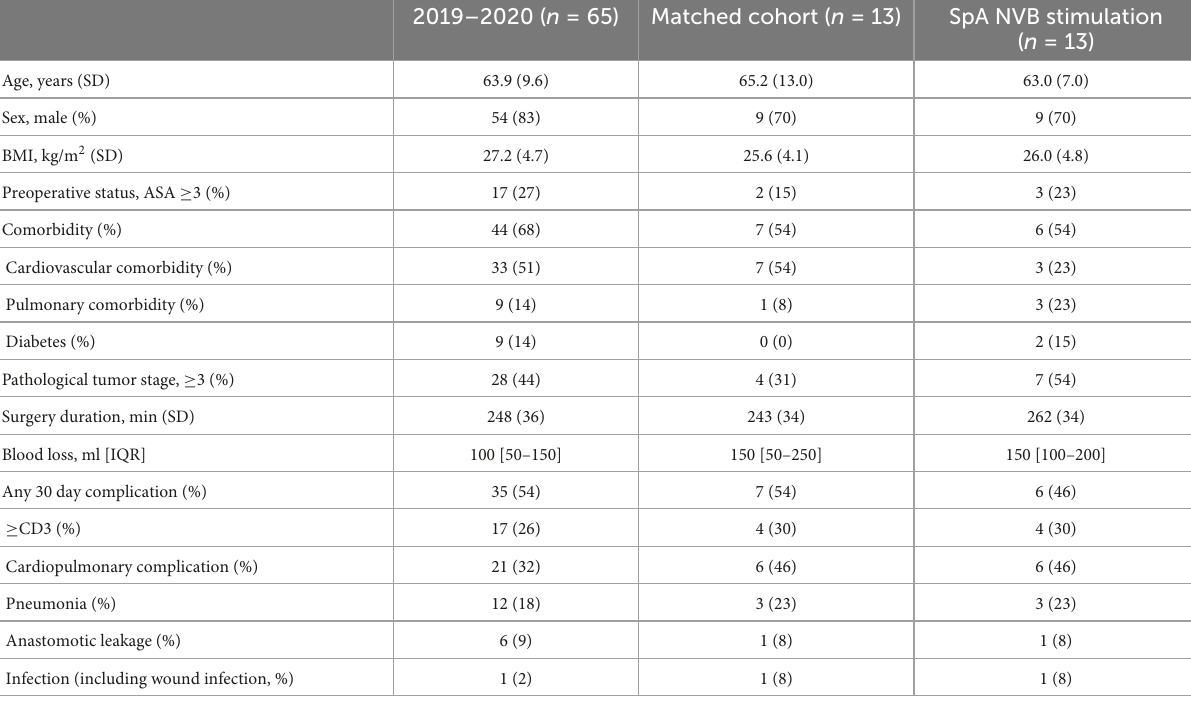
TABLE 4 Baseline characteristics and postoperative complications of all patients that underwent esophagectomy in 2019–2020 (excluding trial participants), the participants in the pilot trial and a complication matched cohort from the 2019 to 2020